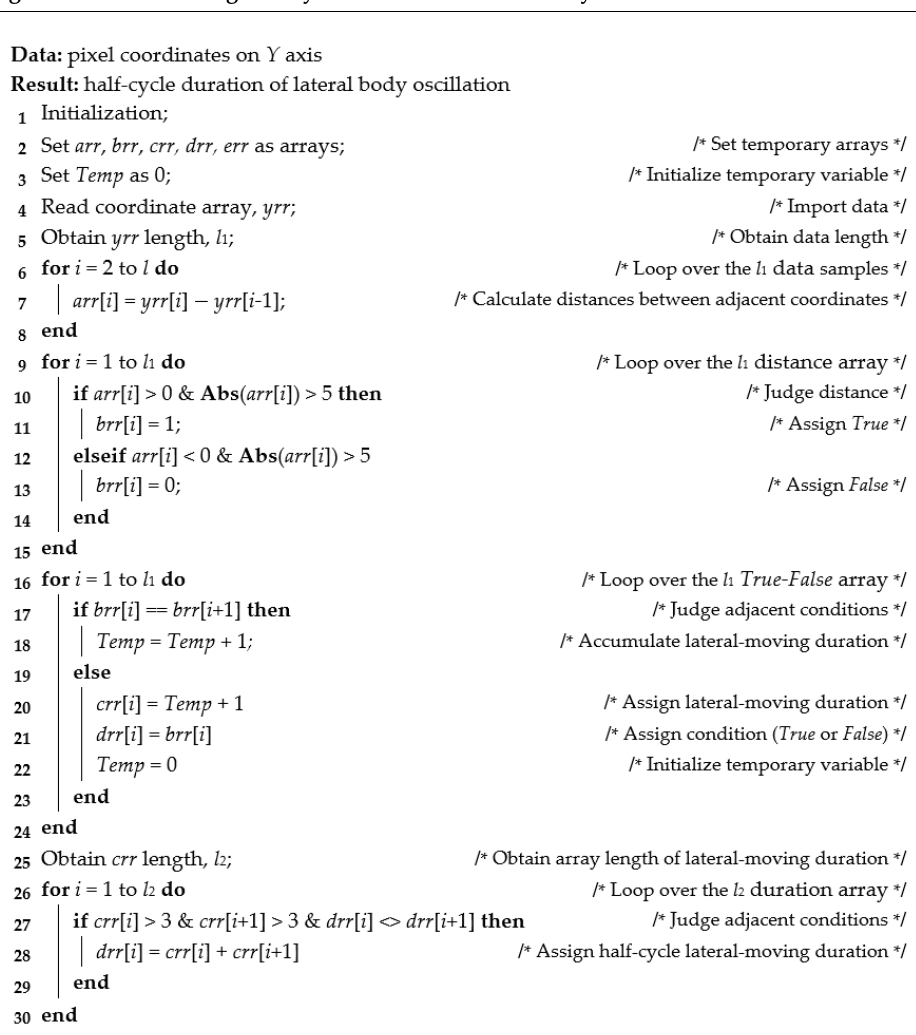
Algorithm 2: Calculating half-cycle duration of lateral body